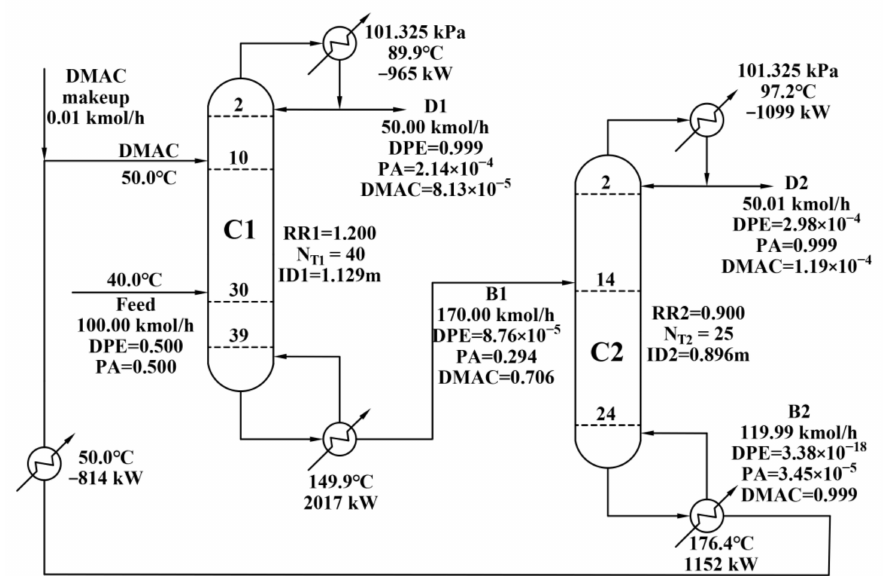
Figure 2. Effect of entrainer flow rate S and reflux ratio RR1 on the purity of DPE.